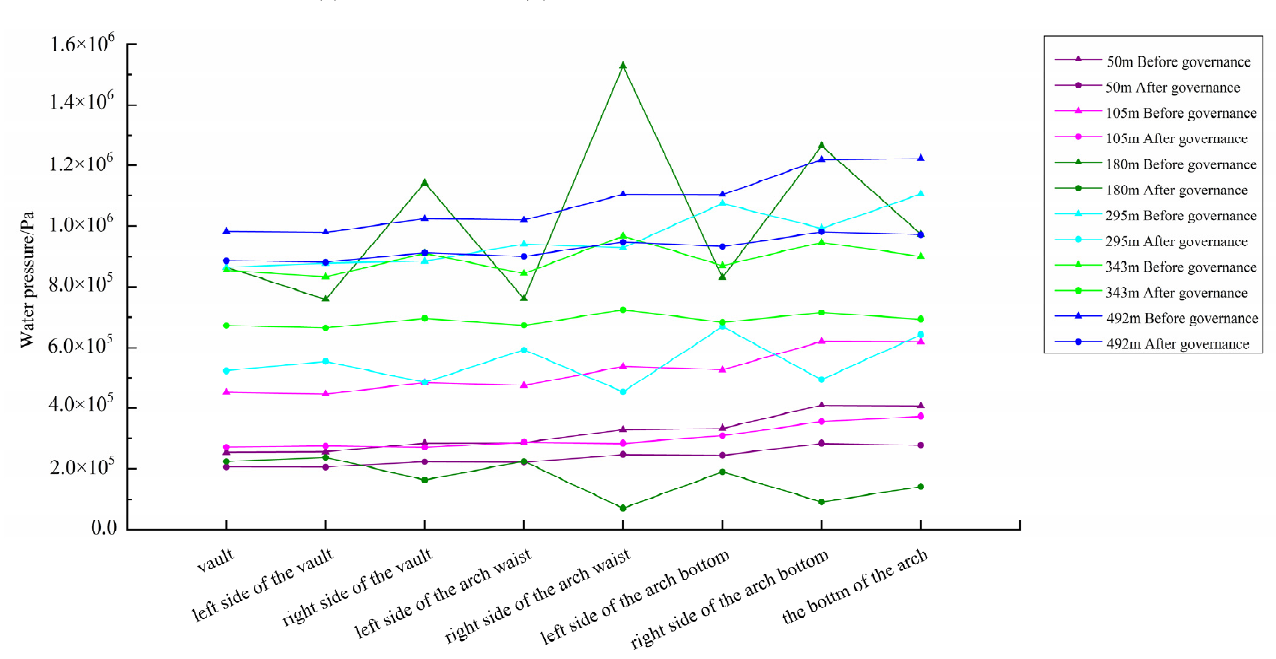
Figure 16. Water pressure at each point before and after